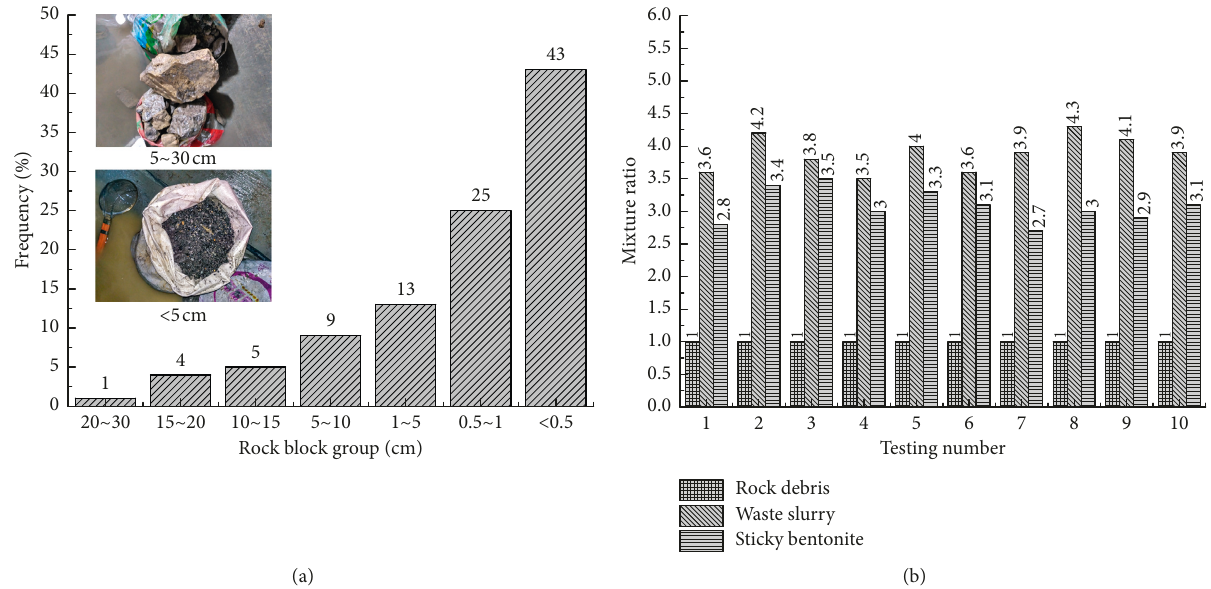
Figure 7: Rock block frequency distribution and sticky mixture ratio of the study area.